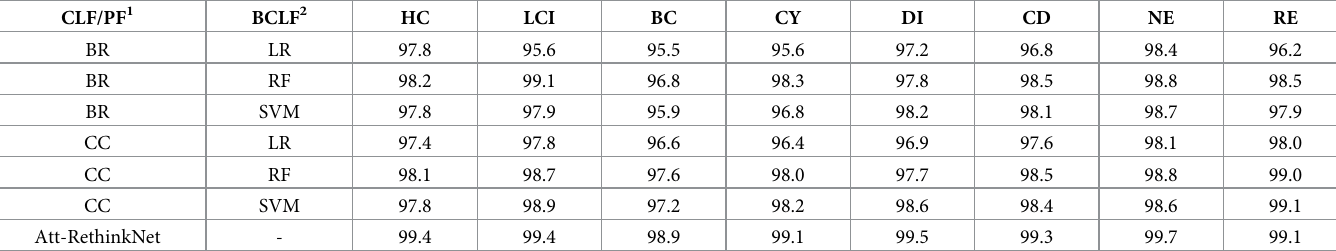
Table 9. Accuracy of all pathological findings for established deep learning models in kidney data. CLF/PF 1